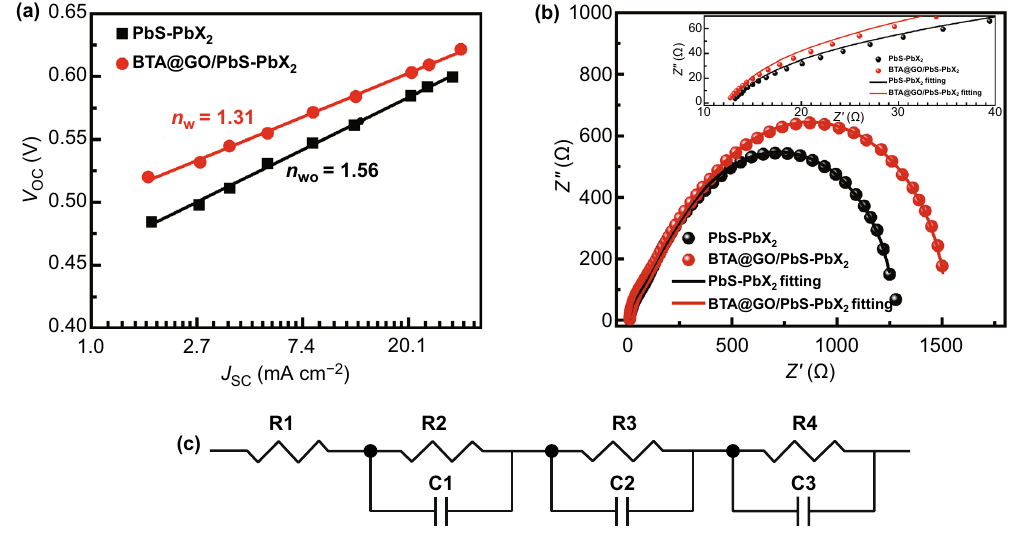
Fig. 6 a V OC plotted against the logarithm of J SC in the CQDSCs device with and without BTA@GO. b Nyquist plots of PbS-PbX 2 CQDs film and BTA@GO/PbS-PbX 2 hybrid CQDs film-based CQDSCs in dark with 0.55 V applied bias, and the solid curves are the fitting results by using the equivalent circuit plotted in c . c Equivalent circuit of CQDSCs